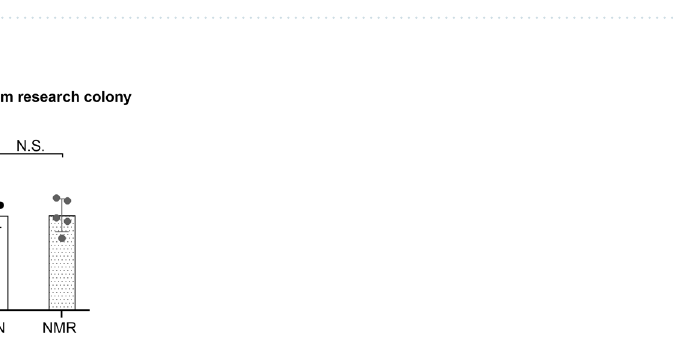
Figure 1. Characterization of the Naked Mole Rat. Detection of the fragmented pattern of 28S ribosomal RNA (rRNA) is characteristic for the NMR. The agarose gel electrophoresis of total RNA from RN and NMR liver is shown and the 28S and 18S of rRNA are indicated. NMR rRNA shows a fragmented pattern, where the 28S rRNA appears cleaved. NMR: Naked Mole Rat; RN: Rattus Norvegicus.